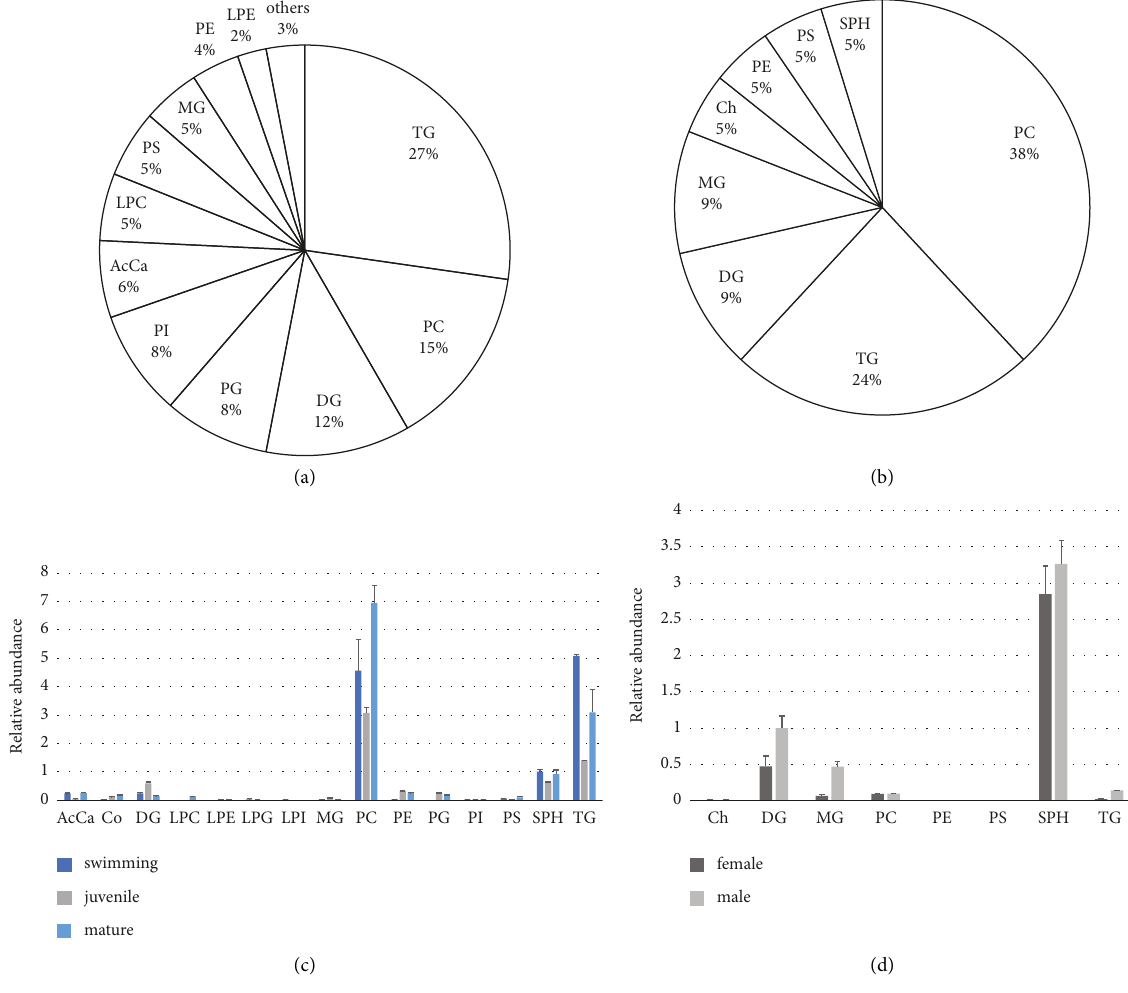
Figure 2: Lipid class composition of abalone. (a) Relative lipid composition of total abalone tissues. (b) Relative lipid composition of total abalone hemolymph. (c) Relative abundance of the normalized average peak area of lipid classes in abalone tissues at three different developmental stages (swimming veliger larvae, juvenile, and mature adults). (d) Relative abundance of the normalized average peak area of lipid classes in the hemolymph of female and male